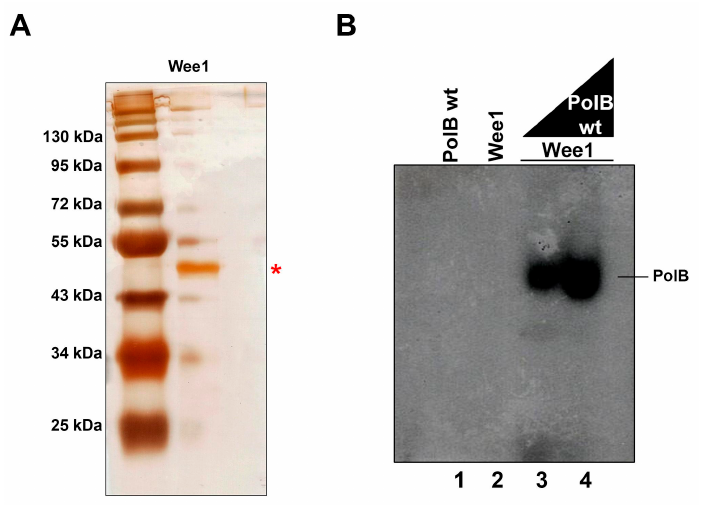
Figure 5. Tcwee1 phosphorylates Tcpol β . The gene encoding a Tcwee1-like kinase was cloned, expressed and the protein purified. ( A ). Fifty ng (50 ng) of purified Tcwee1 was analyzed in a 10%